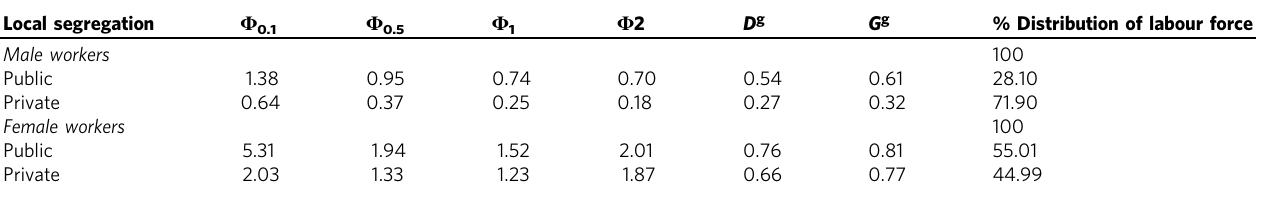
Table 8 Occupational gender segregation by ownership. Local